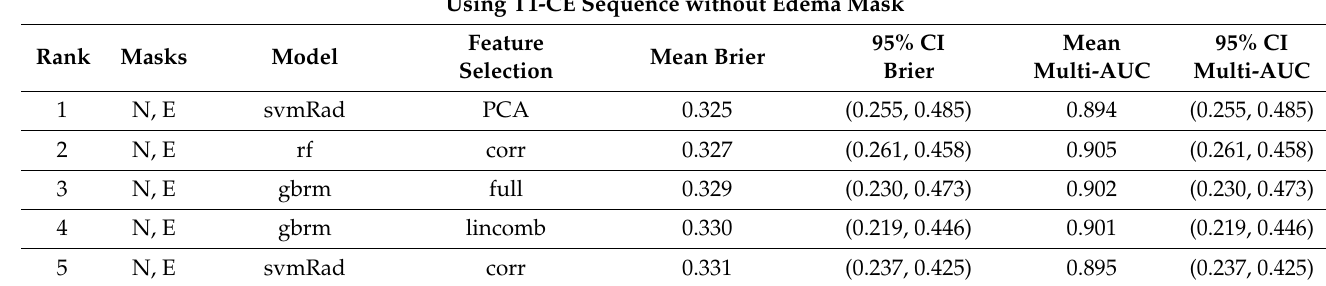
Figure 4A–C display the mean estimate of the cross-validated Brier score for all 45 model and feature selection combinations on both pipelines from all sequences, the best performing individual sequence (T1-CE), and the T1-CE sequence without the edema mask,